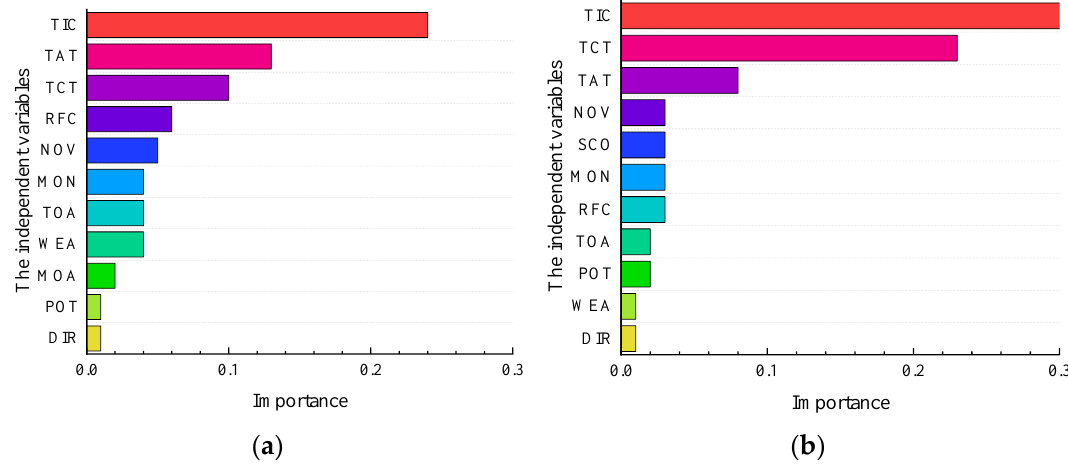
Figure 11. ( a ) The result of the LR in the SSI area; ( b ) The result of the LR in the NSI area.